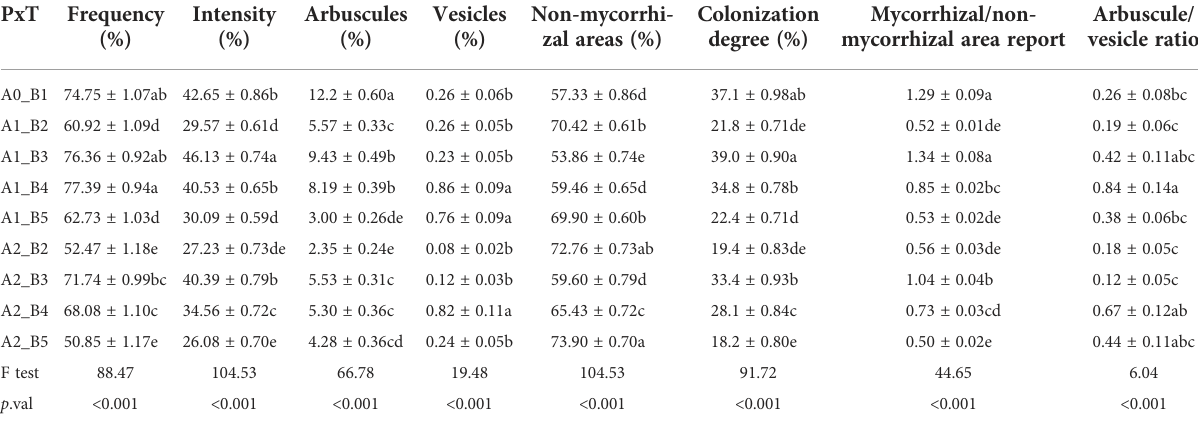
TABLE 1 Differences between mycorrhizal parameters induced by the phenophase × treatment combined effect.